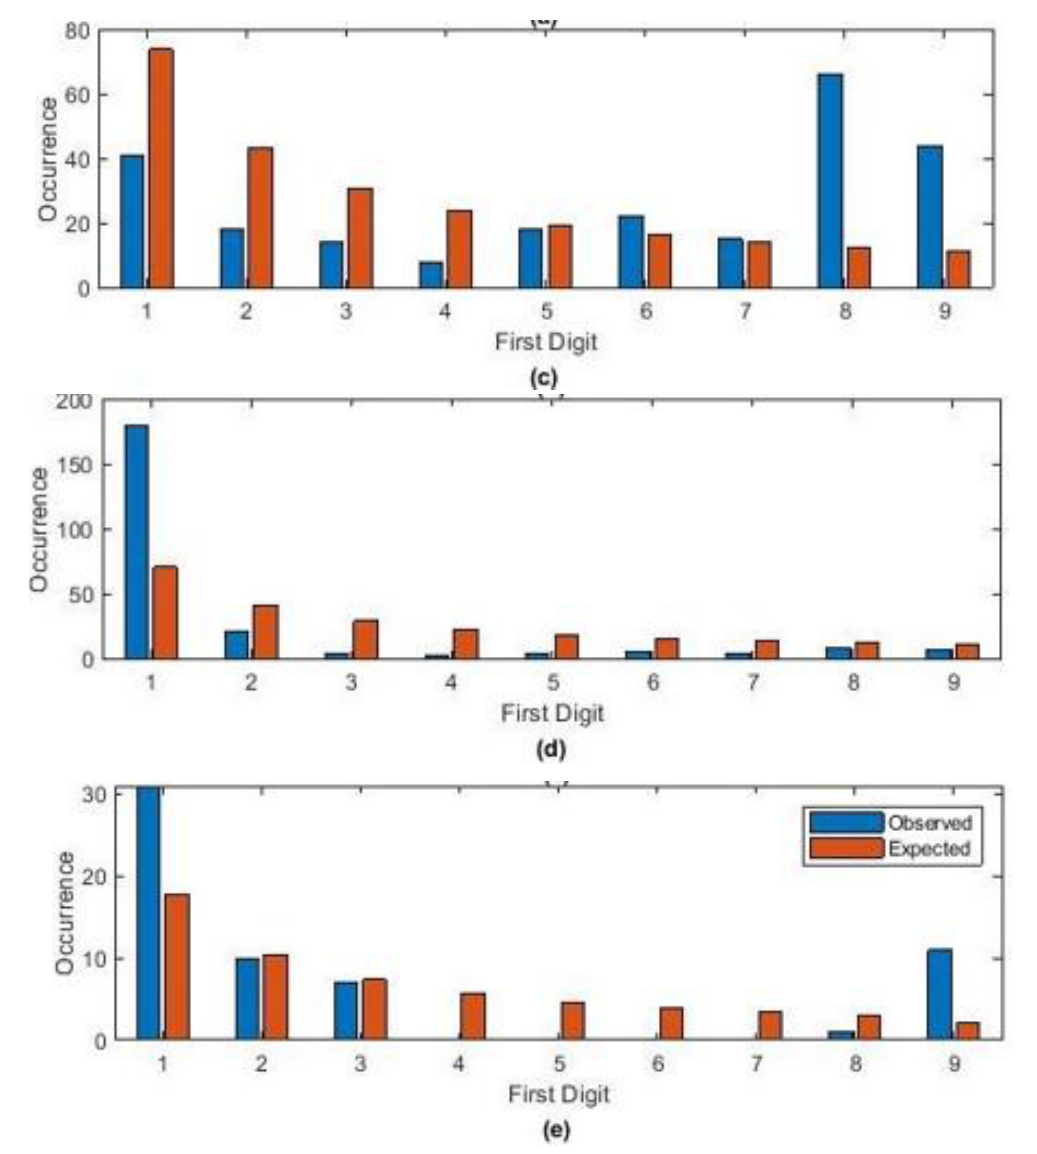
Figure 2. Indonesia and Malaysia NBL distributions a) Indonesia accumulative daily cases; b) Indonesia accumulative mortality cases; c) Malaysia accumulative daily cases; d) Malaysia accumulative mortality cases; e) Malaysia accumulative daily cases (from September 7, 2020 to November 4, 2020).